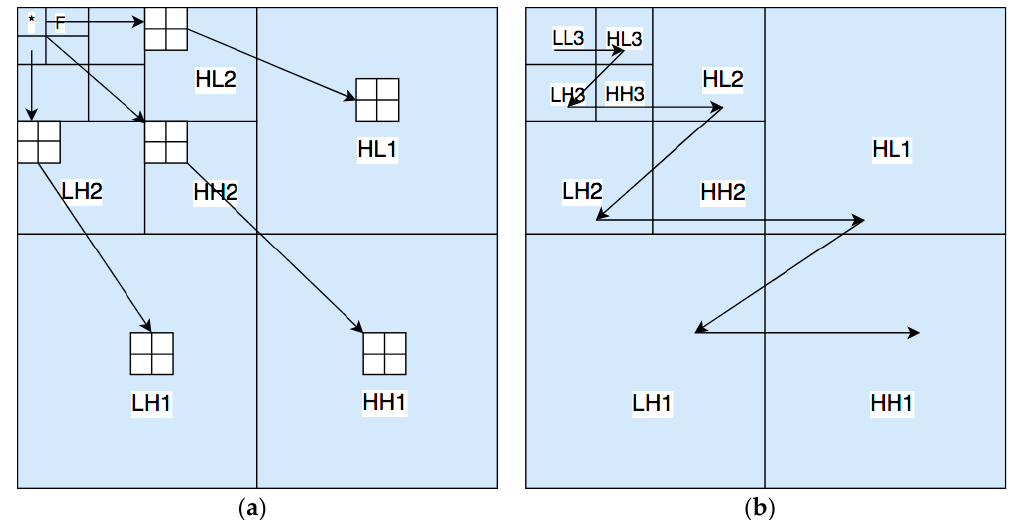
Figure 2. ( a ) SOT parent-child relationship ( b ). Scanning sequence of wavelet coefficients in SPIHT.